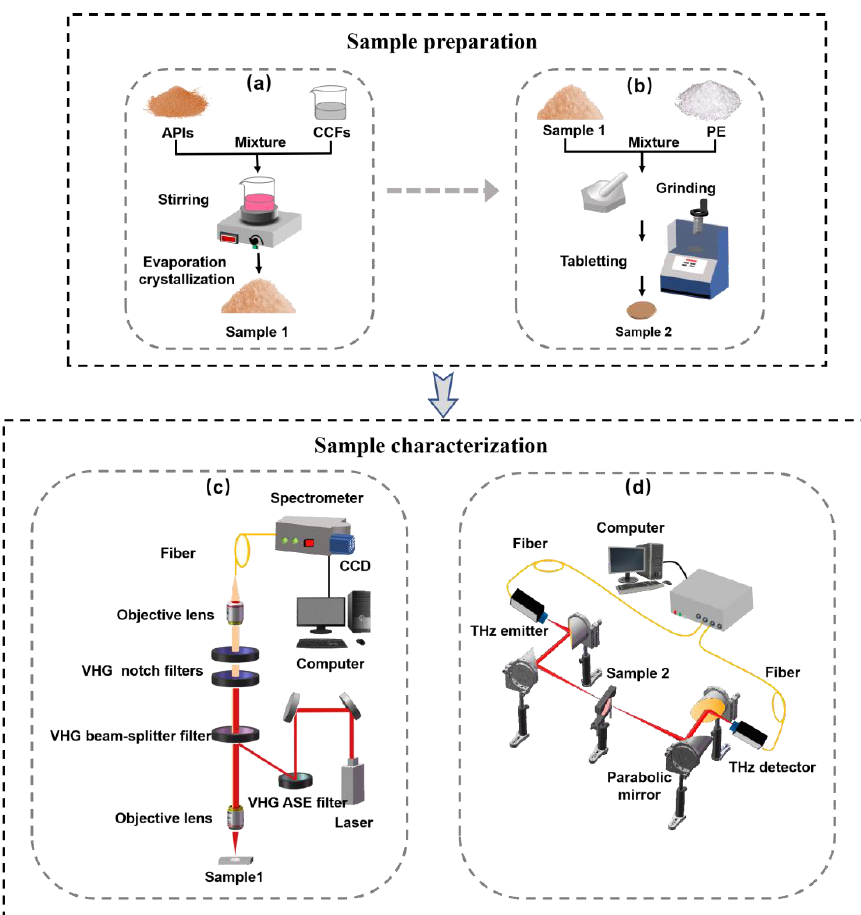
Figure 1. The schematic of the sample preparation and experimental system. ( a ) Co-crystals prepa- ration process; ( b ) tableting process; ( c ) THz-Raman microscope system; ( d ) THz time-domain spec- troscopy system.